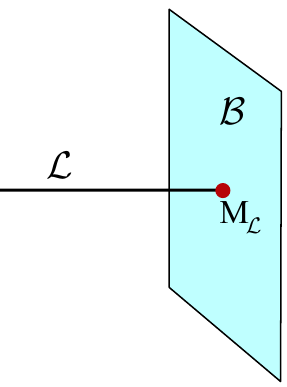
form a module M for the L L